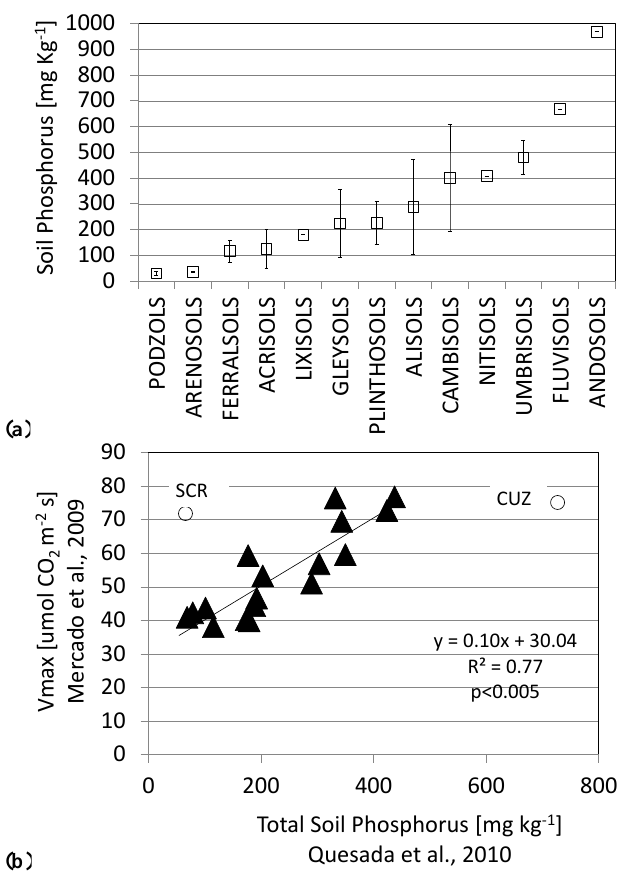
Fig. 3. (a) Total soil phosphorus aggregated by soil type, based on field data from Amazonia, showing the average and standard devia- tion for each soil class; (b) regression between V cmax (Mercado et al., 2009) and total soil P (average depth from 0 to 0.3m; Quesada et al., 2010), excluding CUZ and SCR field site (Supplement D).